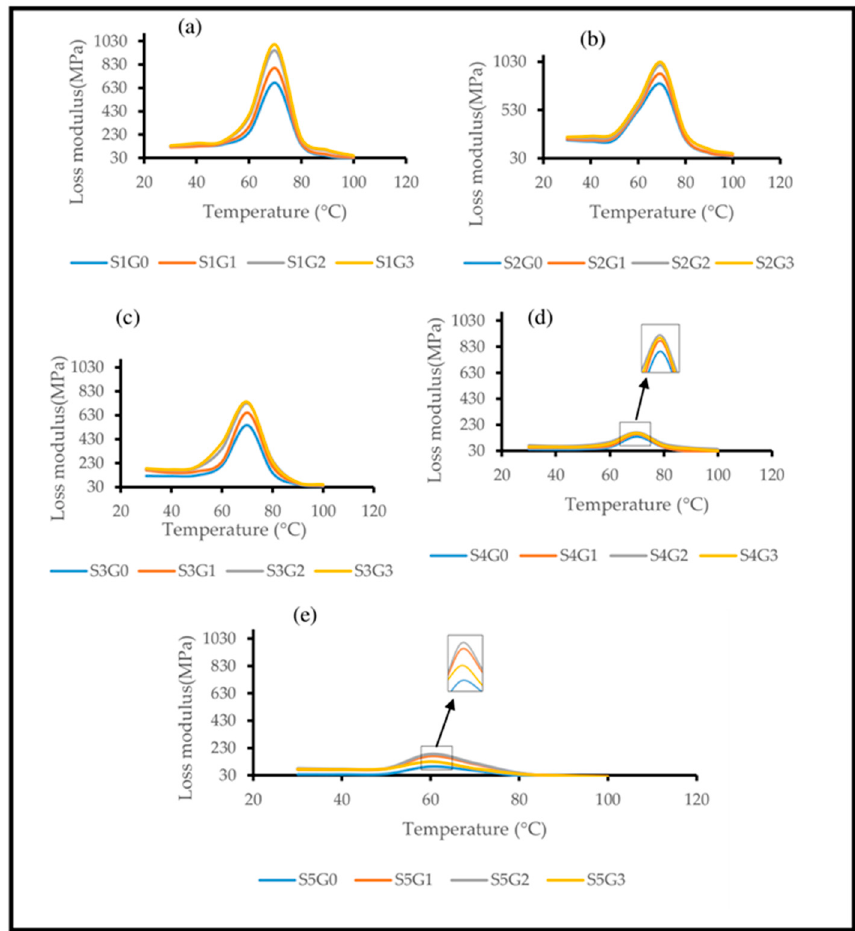
Figure 8. E ff ect of GNP on the loss modulus of laminated composites. ( a ) S1, ( b ) S2, ( c ) S3, ( d ) S4, ( e )